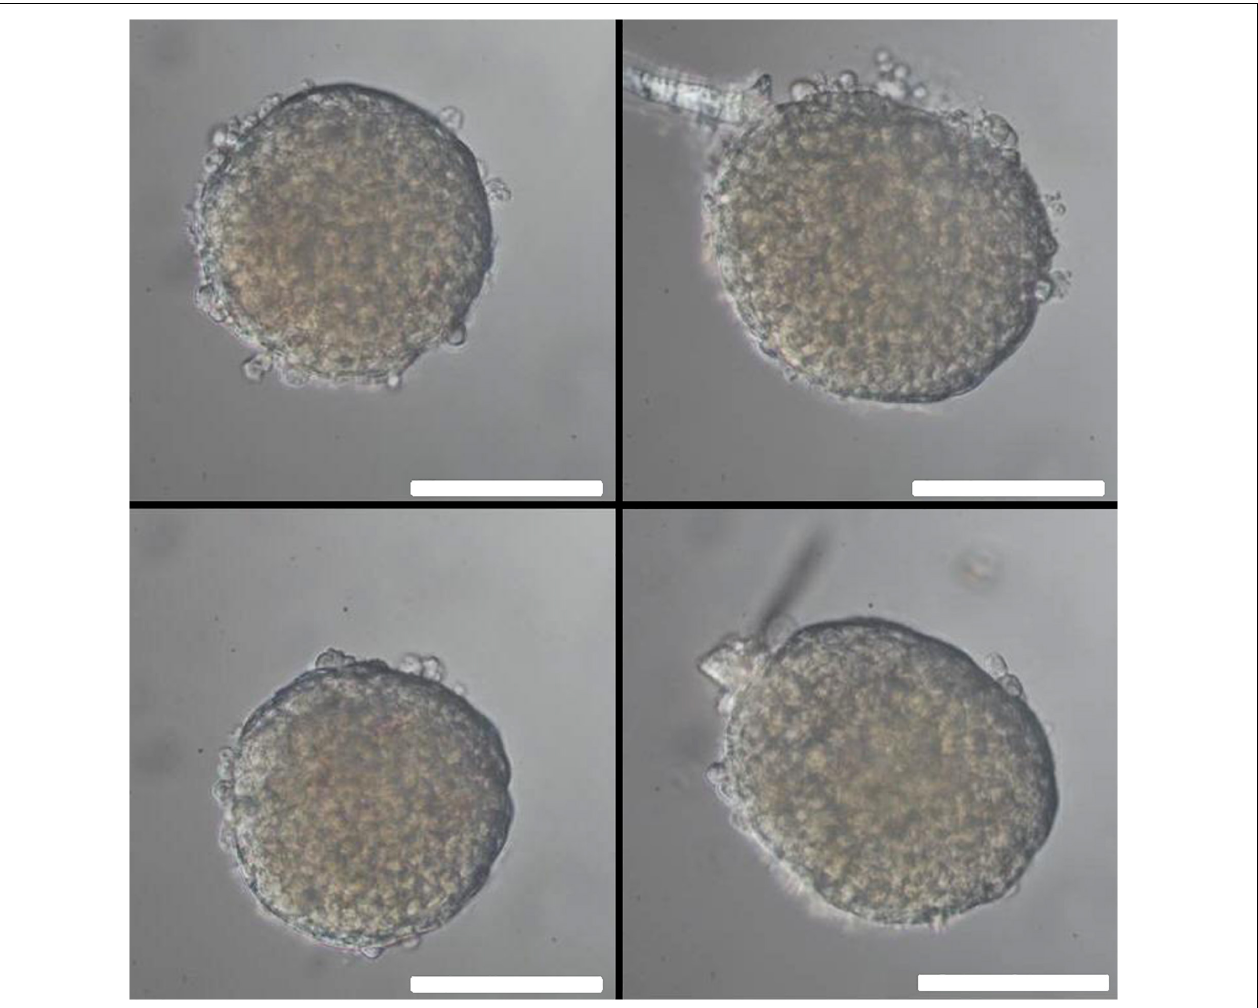
FIGURE 12 | Islet morphology before and after removal from the microfluidic system. One day-cultured mouse islets were placed in the wells as shown in Figure 3a , removed by use of an Eppendorf pipette and inspected by microscopy. Upper row: islet of about 200 µ m (left) and 250 µ m (right) diameter before insertion into the well. Lower row: the same islets after removal from the microfluidic system. Note that the blood vessel remnant of the right islet has been shortened, but otherwise the islets appear intact. DIC-contrast, the length of the scale bar is 150 µ